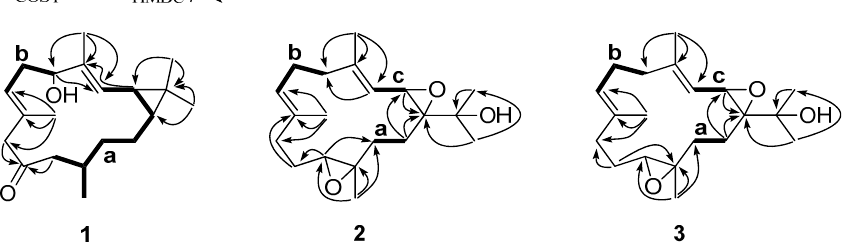
Table 1. 1 H ‐ (500 MHz) and 13 C ‐ (125 MHz) NMR data for 1 – 3 in CDCl 3 .